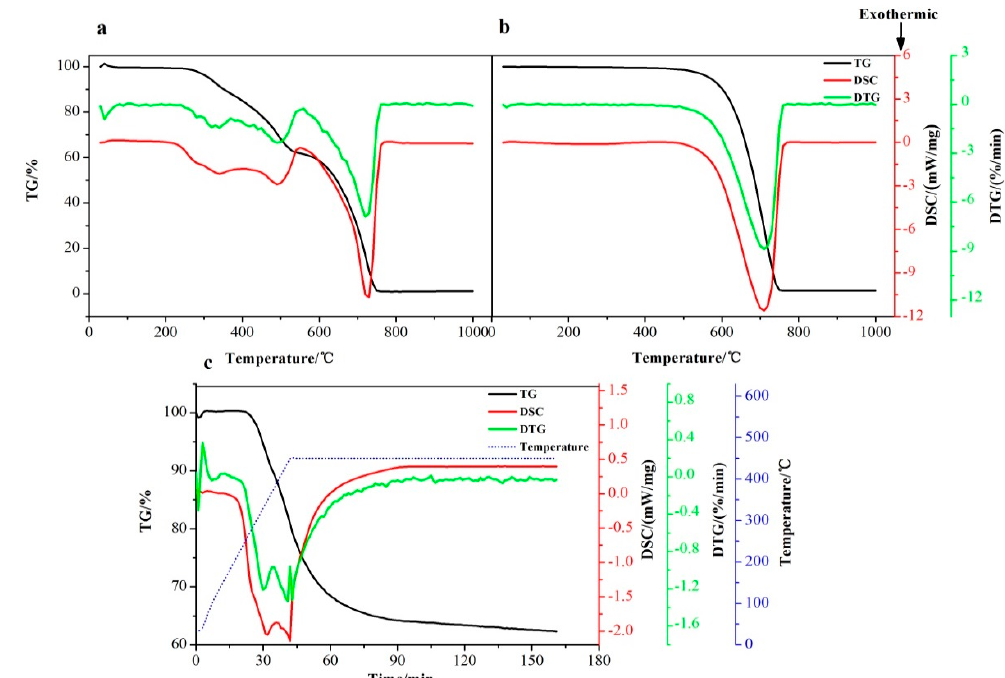
Figure 3. The thermogravimetric analysis (TGA) and differential scanning calorimetry (DSC) results under an oxygen atmosphere: ( a ) CFRP waste, ( b ) virgin carbon fibers, ( c ) CFRP waste maintained for 2 h at 450 °C.